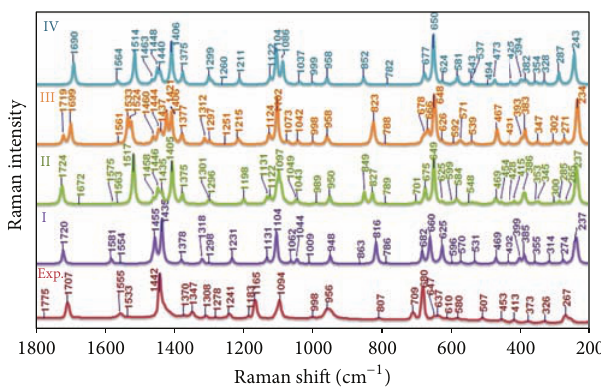
Figure 7: Experimental micro-Raman (solid) and calculated (scaled) Raman intensity spectra of acetazolamide dimer (I–IV) in the region 1800–200 cm −1 , respectively.